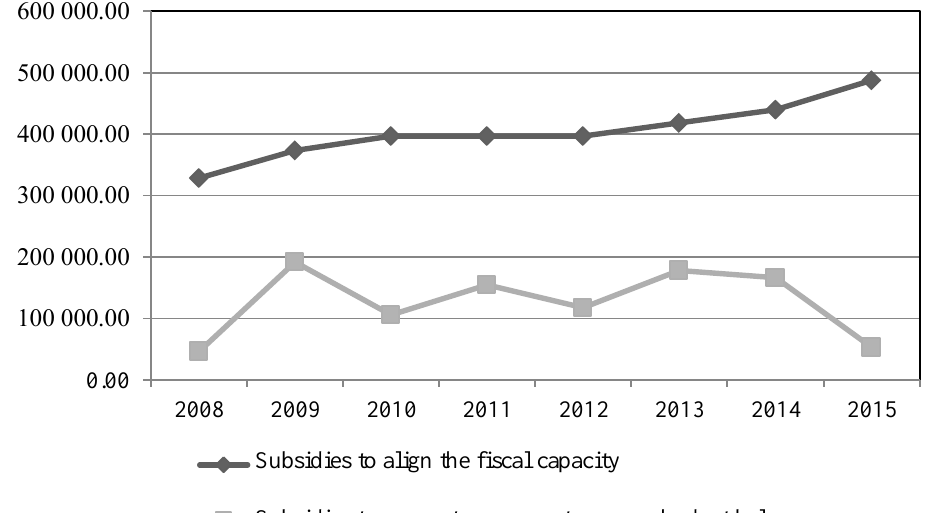
Fig. 10. The trend of the subsidy volume to align the fiscal capacity and to support measures to ensure the budget balance for 2008–2015, in mln rubles (compiled by authors to: [20]).